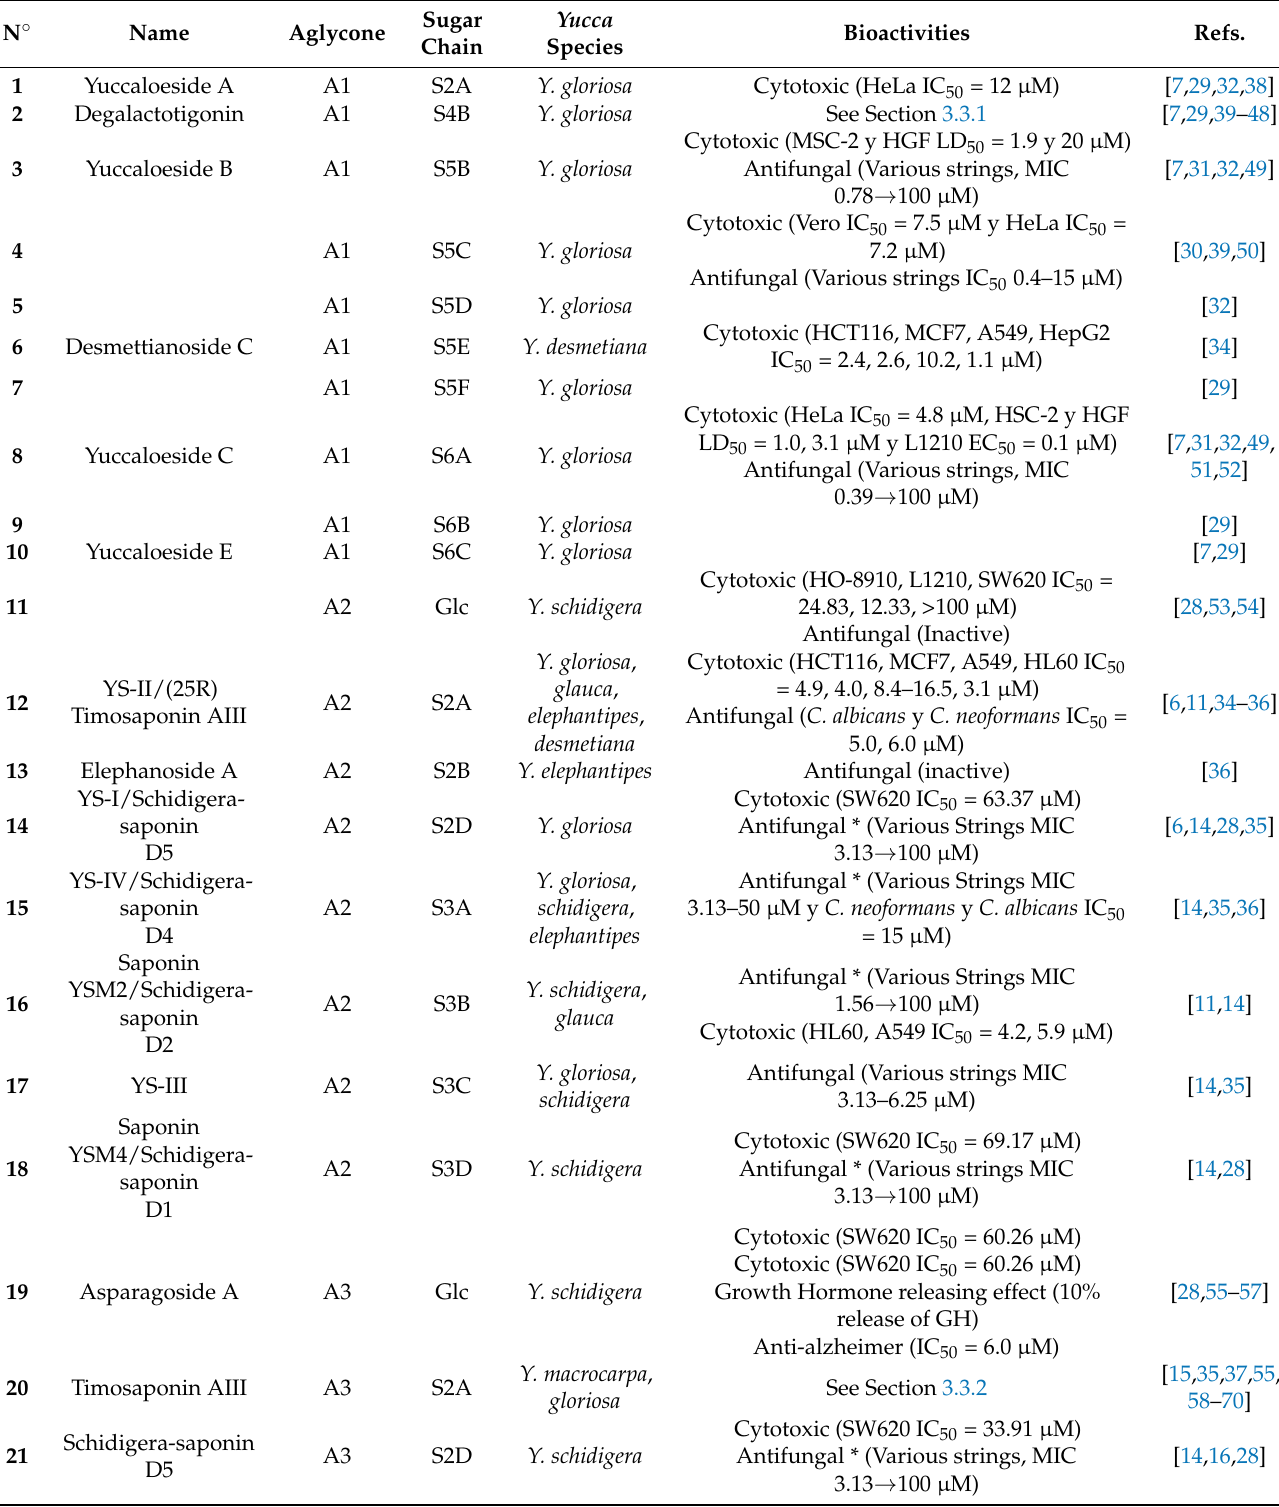
Table 1. Spirostanic and furostanic saponins from Yucca , their origin and